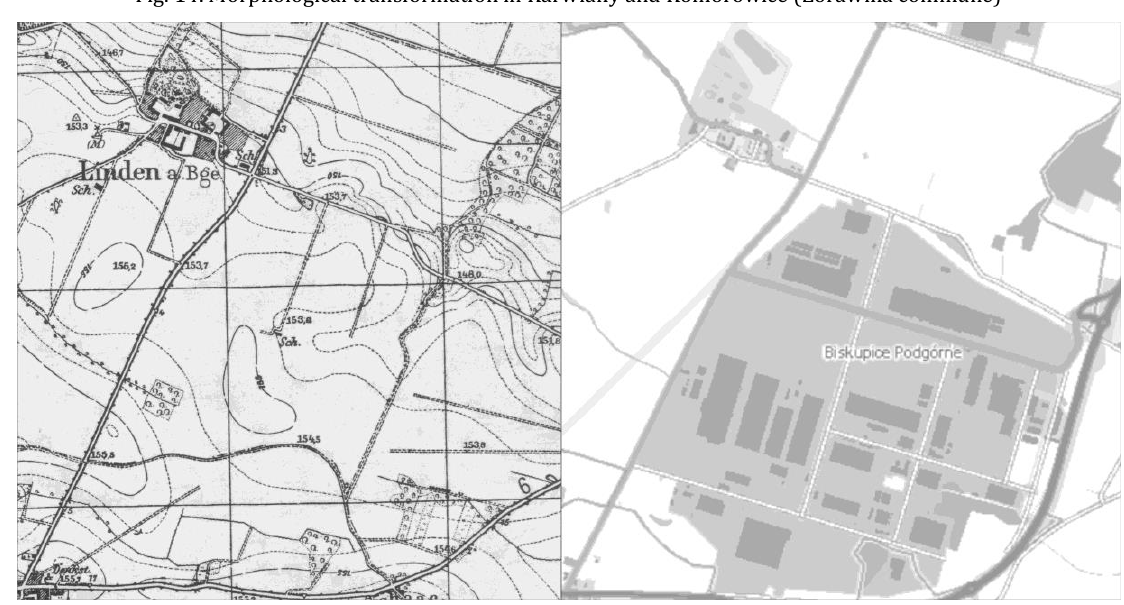
Fig. 14. Morphological transformation in Karwiany and Komorowice (Żórawina commune)